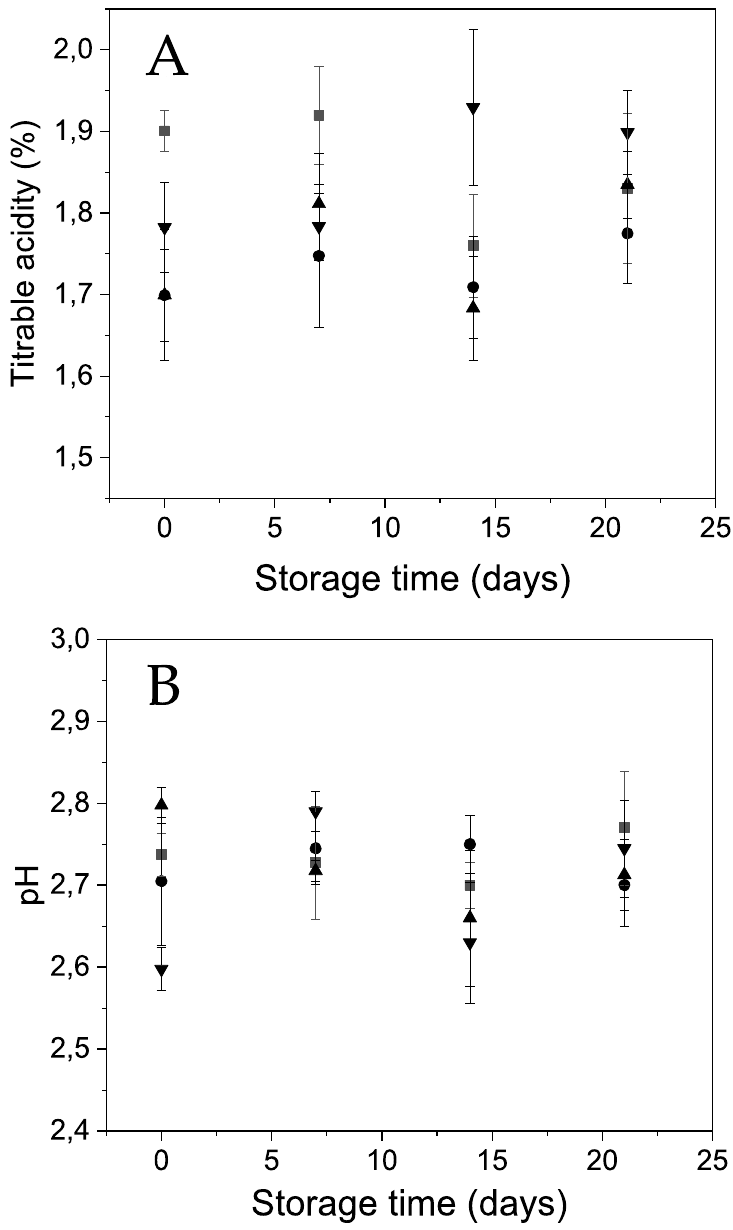
Figure 6. Changes in Andean blueberry pH and titratable acidity (%) during storage. Control ( ■ ), ( (cid:4) ), alginate ( • ), alginate / CNFs 0.1% ( (cid:78) ), alginate / CNFs 0.3% ( (cid:72) alginate (●), alginate/CNFs 0.1% ( ▲ ), alginate/CNFs 0.3% ( ▼ ).